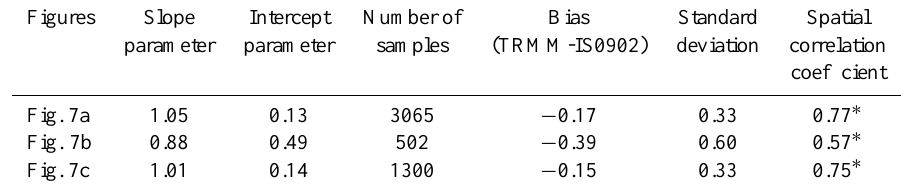
Fig. 8. Spatial distribution of temporal correlation of average annual rainfall in IS0902 and TRMM_3B42 from 1998 to 2006.